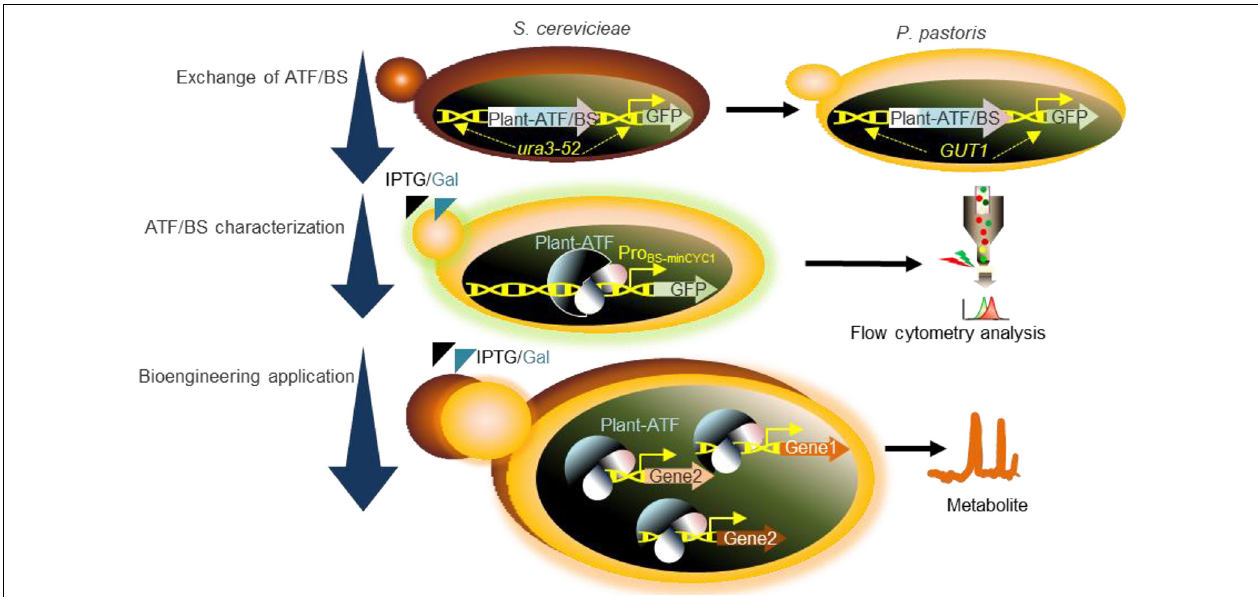
FIGURE 1 | Schematic overview of the workflow used in the present study. Exchange of ATF/BSs: our plant-derived GFP-ATF/BSs deriving GFP expression, previously characterized following integration into the ura3-52 locus of S. cerevisiae (Naseri et al., 2017), were inserted into the GUT1 locus of P. pastoris . ATF/BS characterization: following the addition of IPTG and galactose (inducers), GFP expression was determined by flow cytometry. Bioengineering application: characterized ATF/BSs were employed to tune the protein expression levels required for metabolic engineering in P. pastoris . ATF/BS, artificial transcription factor and its corresponding binding site; GUT1, glycerol utilization 1; Pro BS - minCYC 1 , synthetic promoter containing the binding sites of plant TFs upstream of the minimal CYC1